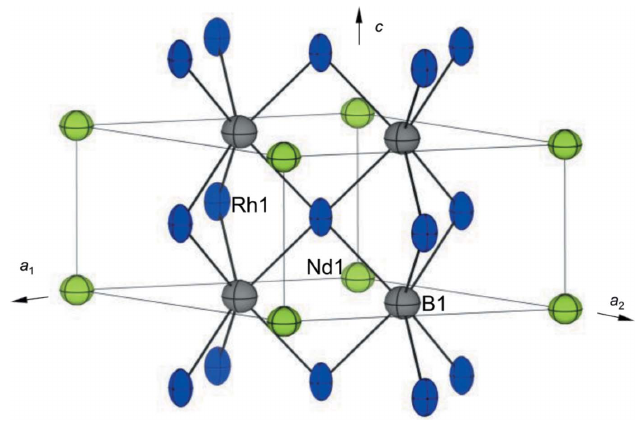
Figure 3 Displacement ellipsoids of each atom in NdRh 3 B 2 , with displacement ellipsoids drawn at the 99% probability level.